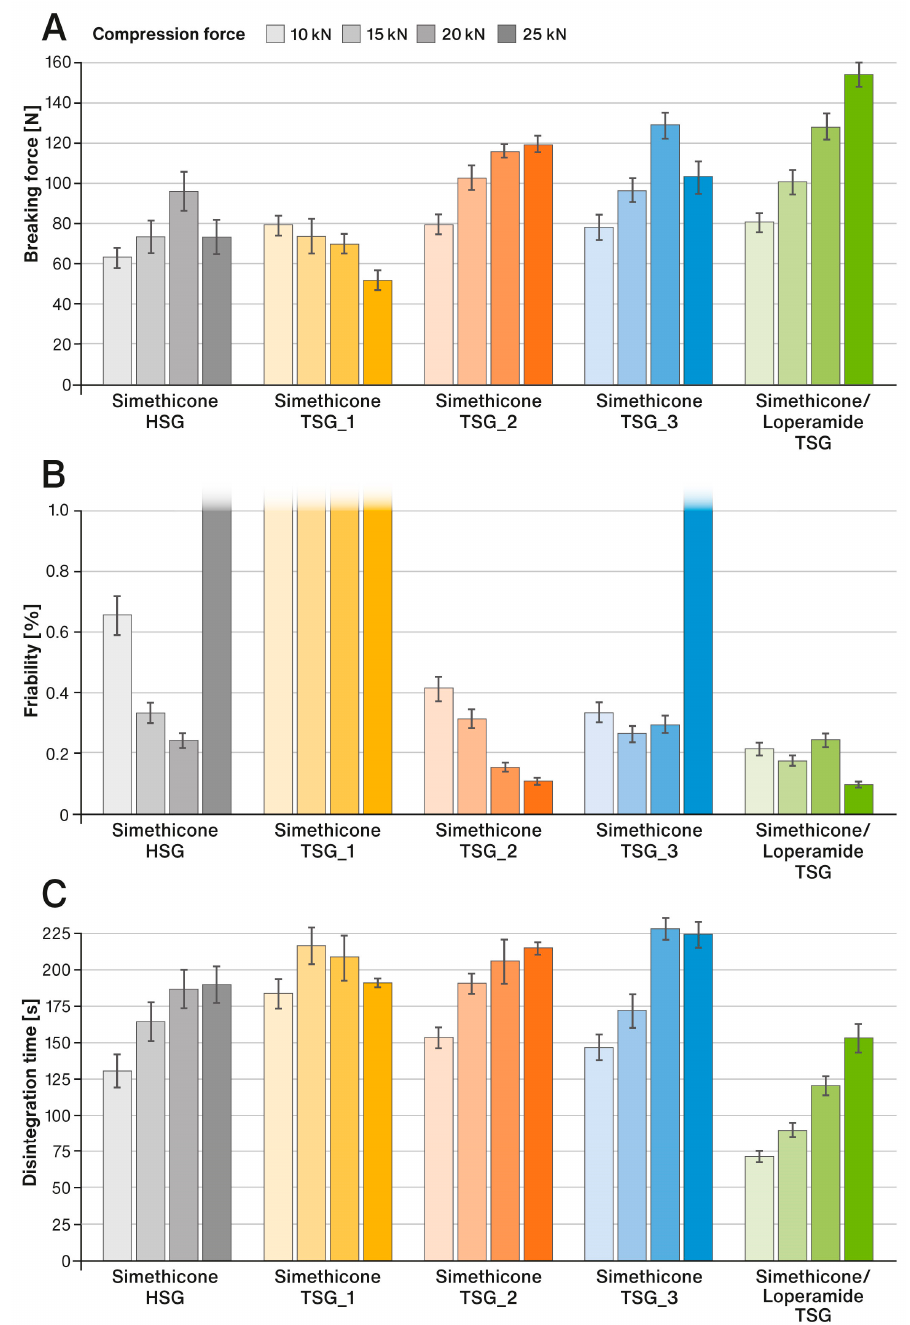
Figure 4. Comparison of ( A ) hardness (breaking force); means of n = 10, ( B ) friability; means of n = 3, ( C ) disintegration time; means of n = 6 of liquisolid formulations compressed under various compression forces. SD is indicated by the error bars.